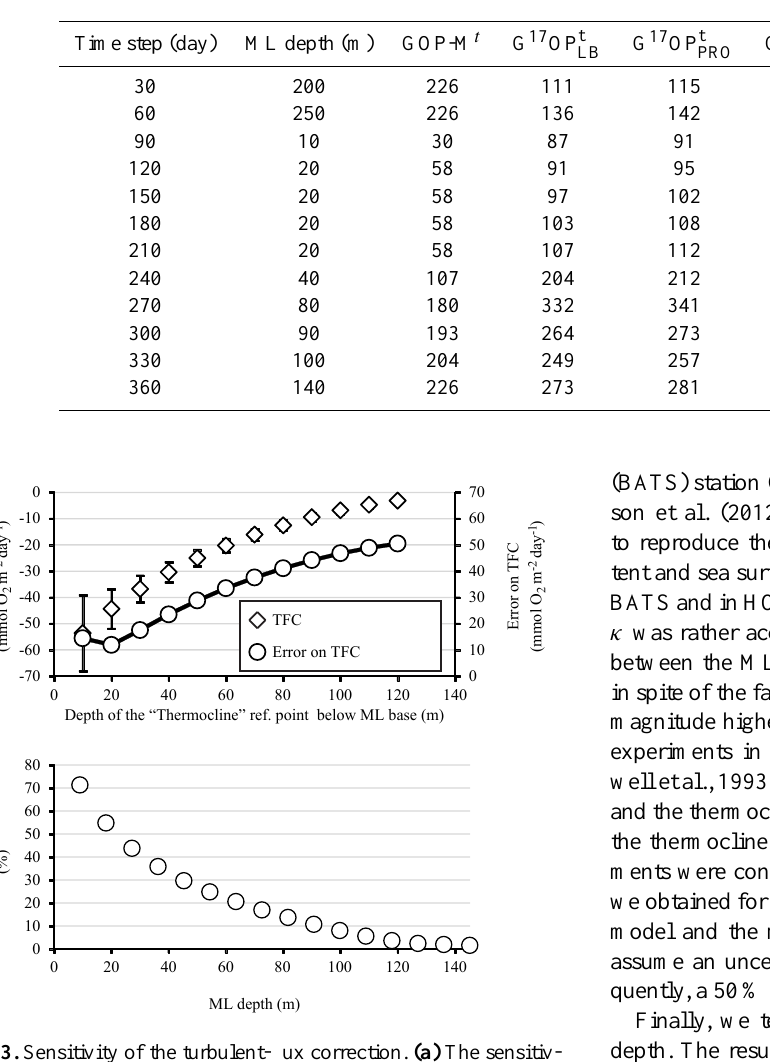
Fig. 3. Sensitivity of the turbulent-flux correction. (a) The sensitiv- ity of the GOP correction for turbulent flux of O 2 from the thermo- cline (TFC) to the depth of the “thermocline” reference point below the mixed layer (ML). The error bars represent the maximal error on the TFC, induced by the analytical error associated with 17 1 mea- surements (7 per meg). The error resulting from the combination of these two factors (circles) on the TFC shows a minimum at 20m below ML. (b) The relative contribution of turbulent mixing flux to estimated G17OP as a function of the ML depth. Model conditions for each sensitivity test are described in Sect. 4 in the